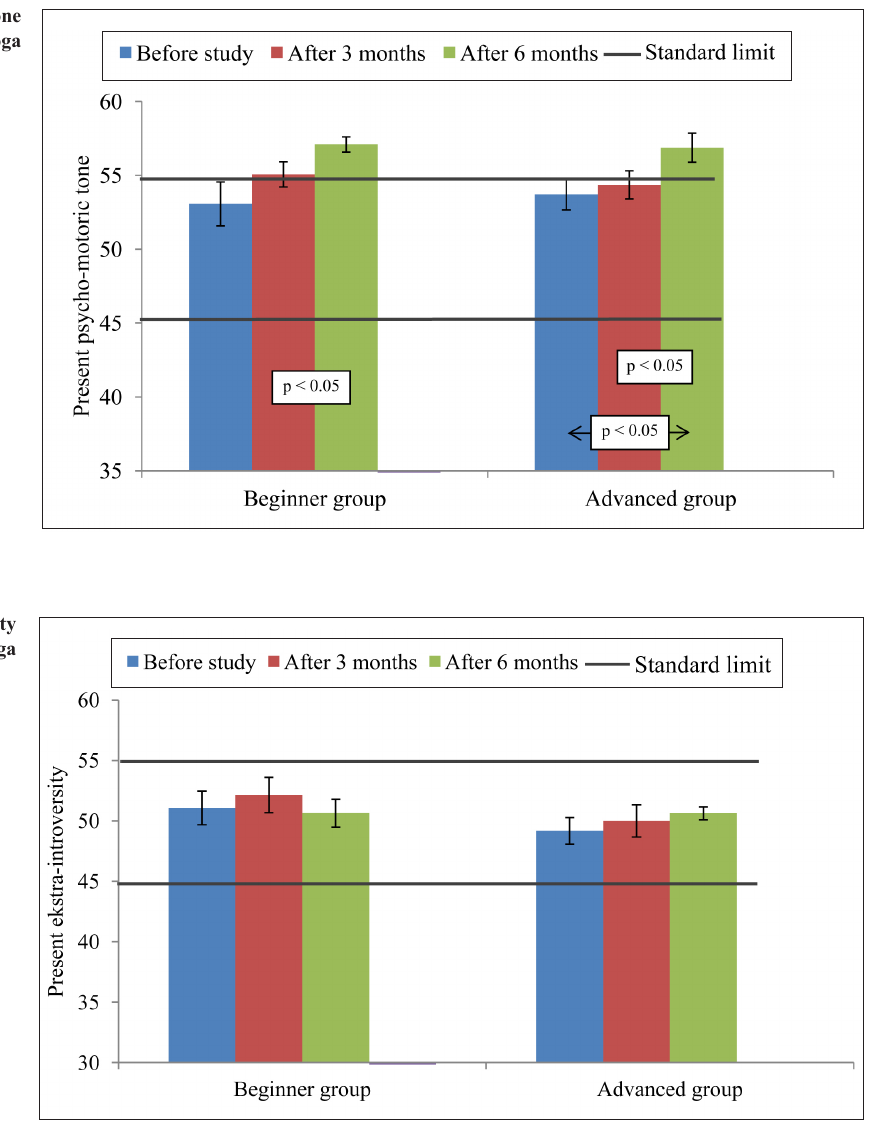
Figure 2. Present psychomotoric tone in the beginner and advanced yoga groups